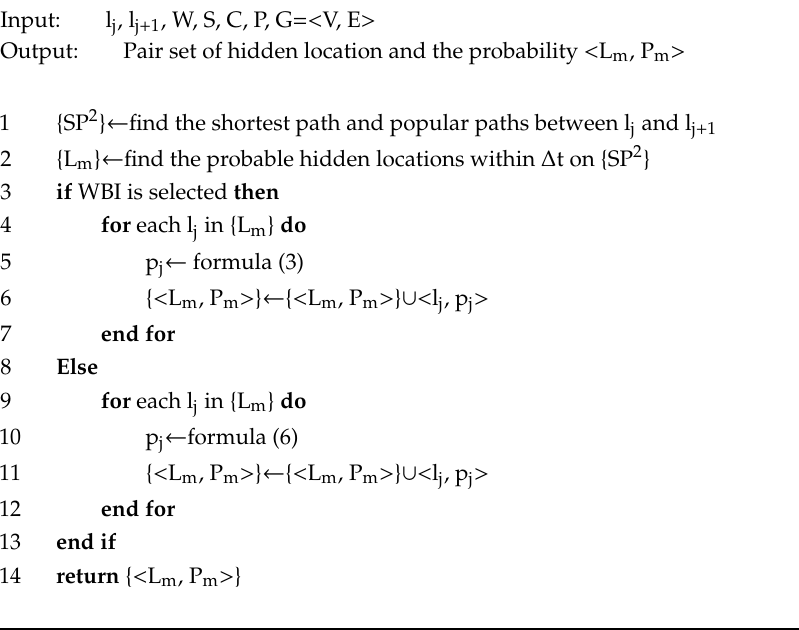
Algorithm 1. Hidden Location Inference Algorithm.